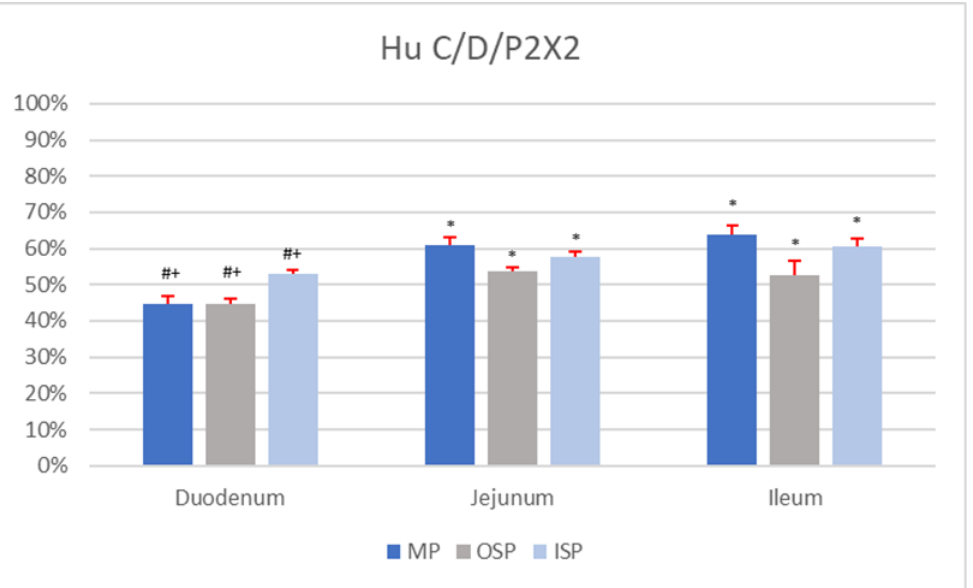
Figure 1. Percentage of Hu C/D-IR/P2X2-IR nerve cells in individual nerve plexuses (MP, OSP, and ISP) of the duodenum, jejunum, and ileum. Statistically significant differences ( p < 0.05) between the mean number of Hu C/D-IR/P2X2-IR neurons present in analogous nerve plexuses of different sections of the small intestine are marked: * vs. duodenum, # vs. jejunum, + vs. ileum. In the MP of the duodenum, Hu C/D-IR/P2X2-IR neurons constituted 44.78 ± 2.24% of nerve cells (Figure 1). In a single MP ganglion (mean area 2826.15 ± 149.87 µm 2 ; mor-